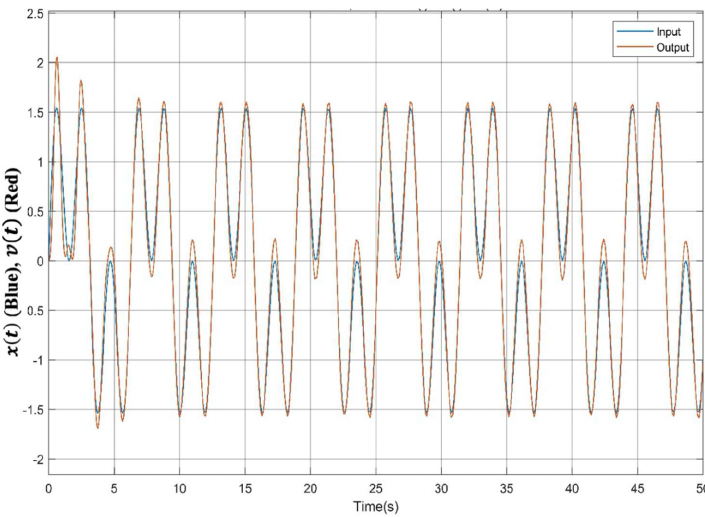
Figure 9. Response to Step Input with Technique 4. Note on Control Design: It was assumed that 𝛼 = 𝛽 = 0.5 in the development of the 𝑃𝐼 (cid:3081) 𝐷 (cid:3080) feedback compensation. The control gains were chosen based on iterations per- formed using Monte-Carlo simulations. As noted in [35], analytical techniques for the se-